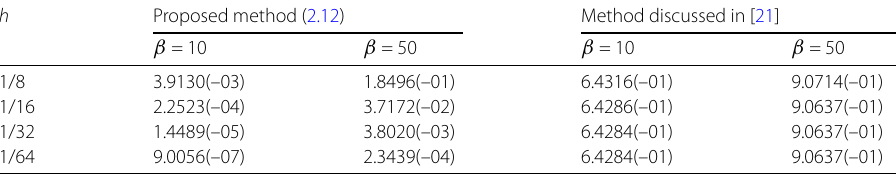
Table 1 Problem 8.1: The maximum absolute